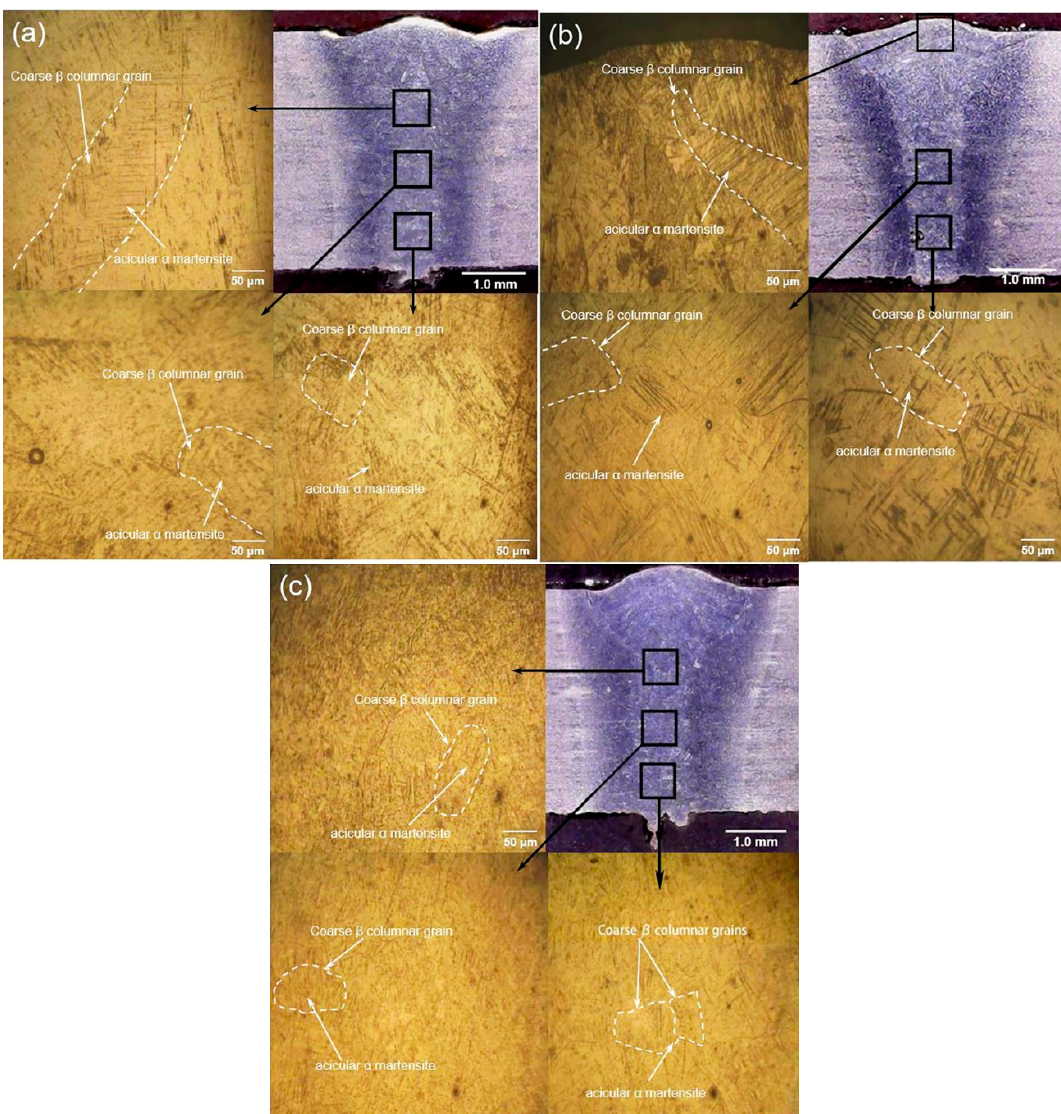
Figure 4. The microstructure of the weld ( a – c ): ( a ) sample I; ( b ) sample II; ( c ) sample III.